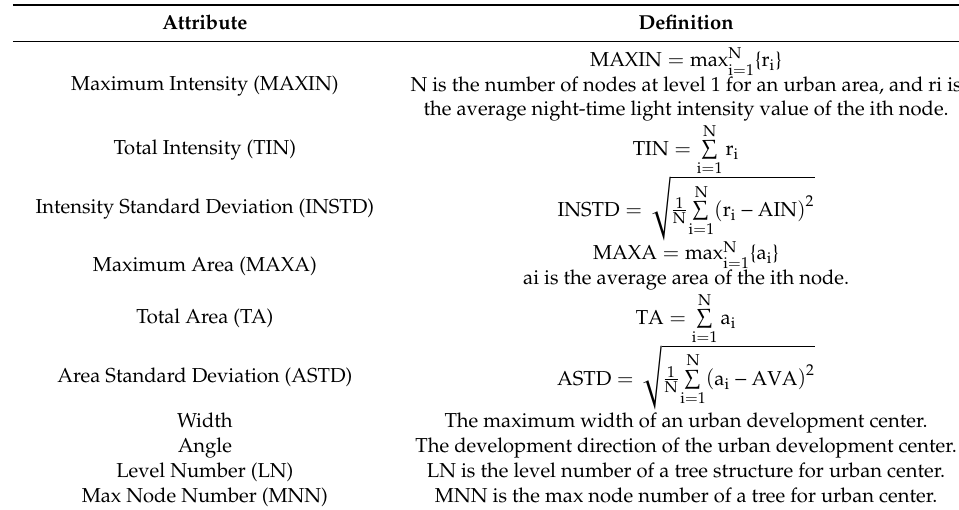
Table 2. City analysis parameter